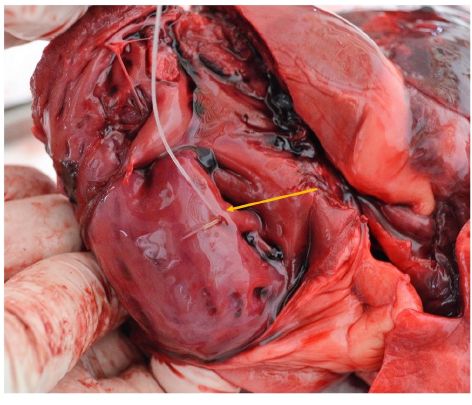
→ Entangled worm at the trabeculae carneae. Figure 5. Post mortem examination of the dog which died due to heartworm infection showing an entangled worm at the trabeculae carneae of the right ventricle.